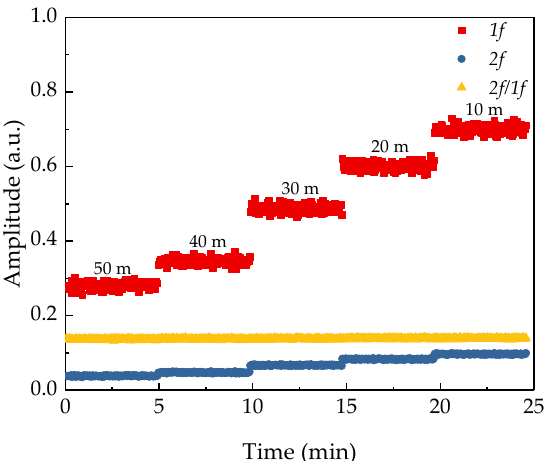
Figure 6. The change trend of the first harmonic, second harmonic, and the 2f/1f signal of the absorbed signal versus the remote sensing distance.